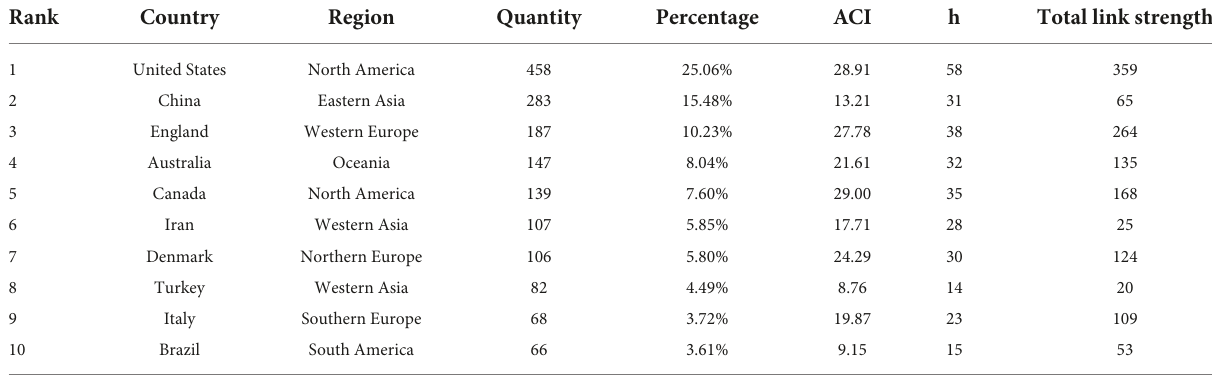
TABLE 1 Top 10 productive countries regarding the research on vitamin D and reproductive